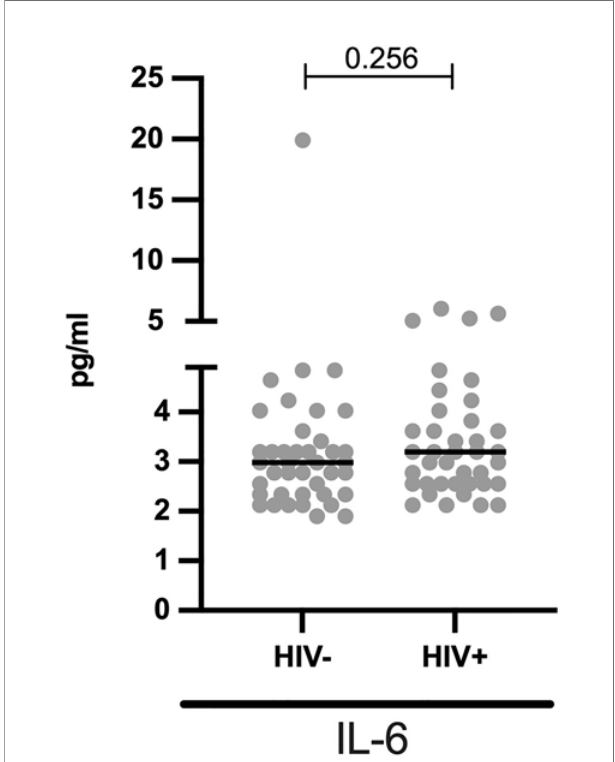
FIGURE 2 | Comparable systemic IL-6 levels in HIV- and HIV+ children: Concentrations of IL-6 (pg/ml) are strati fi ed by HIV status. Each dot represents an individual volunteer, the median is indicated. Statistical analysis was performed using the Mann-Whitney